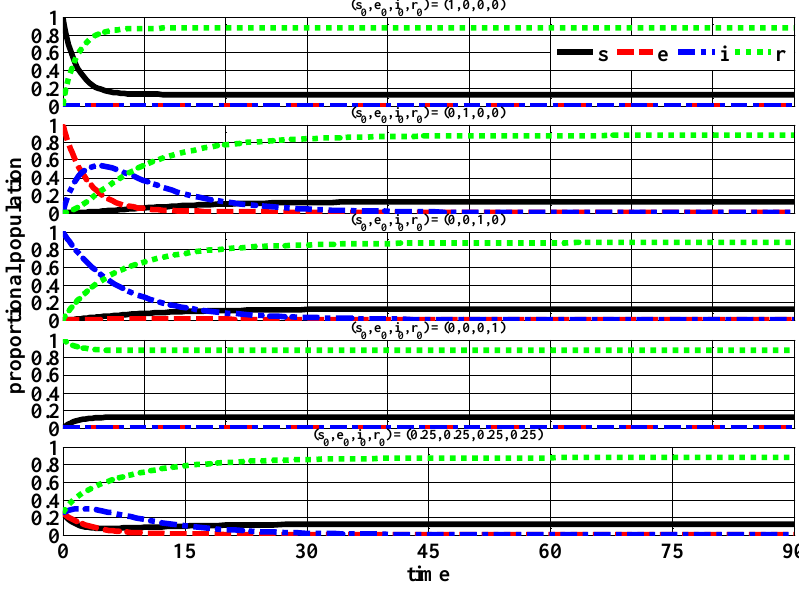
Figure 2. Proportional Populations (β = ¼ (No Epidemic)).